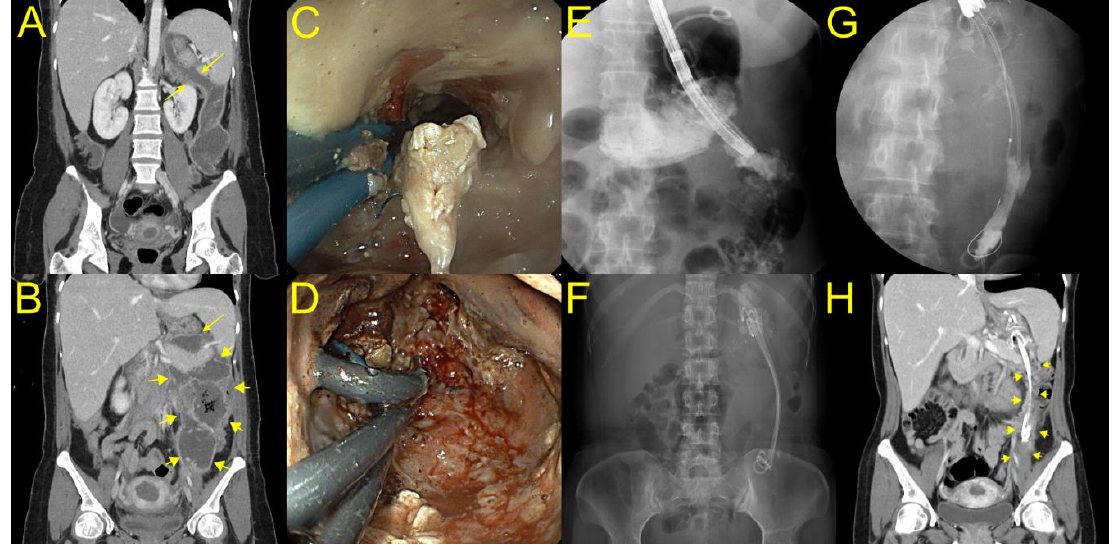
Figure 3. A case of elongated WON extended to the left paracolic gutter. ( A , B ) Computed tomography showing that an elongated WON (yellow arrow) extended to the left paracolic gutter was concatenated with the stomach. ( C – E ) A gastroscope was inserted into the proximal portion of the cavity through a lumen-apposing metal stent (LAMS), and we found a long narrowing WON endoscopically and radiologically. ( F ) After DEN, three plastic stents with double pigtail configuration remained in place through LAMS to the deep portion of WON until the next session of DEN. ( G ) After nine DEN procedures, long plastic stents remained in the deep portion of WON with partial improvement radiologically. ( H ) After 11 DEN sessions, where the long plastic stents remained in the deep portion of WON, the patient recovered with complete WON resolution (yellow arrow).